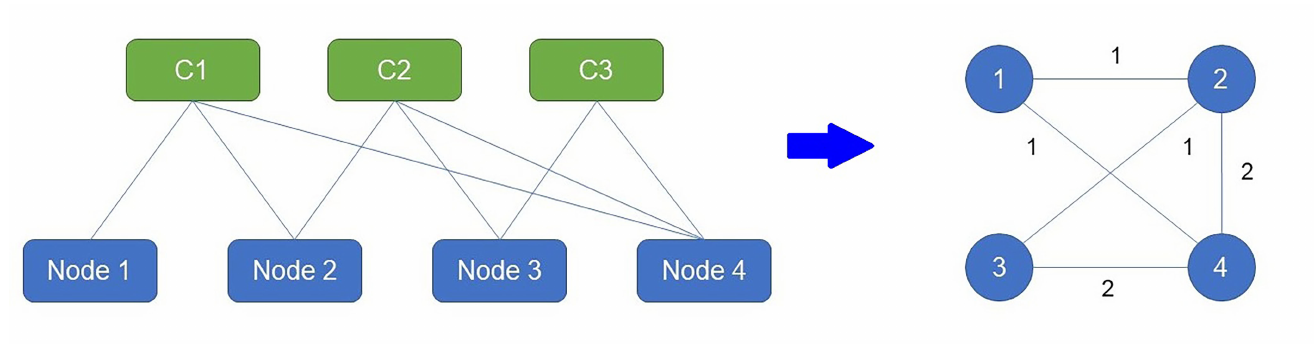
Figure 2. An analogy based on a co-product purchases network used in market basket analysis to generate a communication network in the node-based